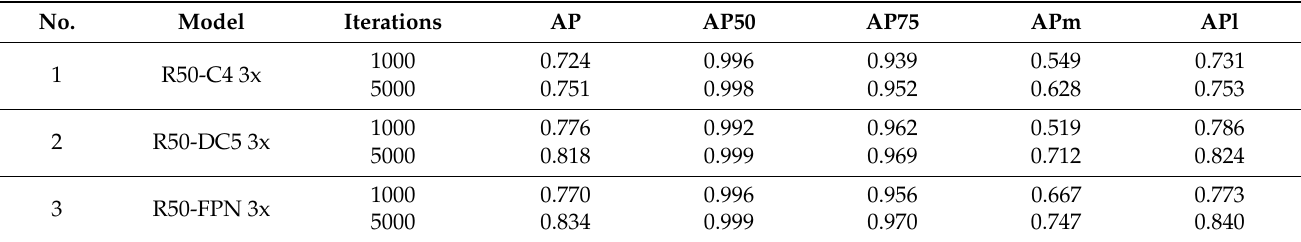
Table 3. Comparison of Various Models and Repeated Test Results (Segmentation).